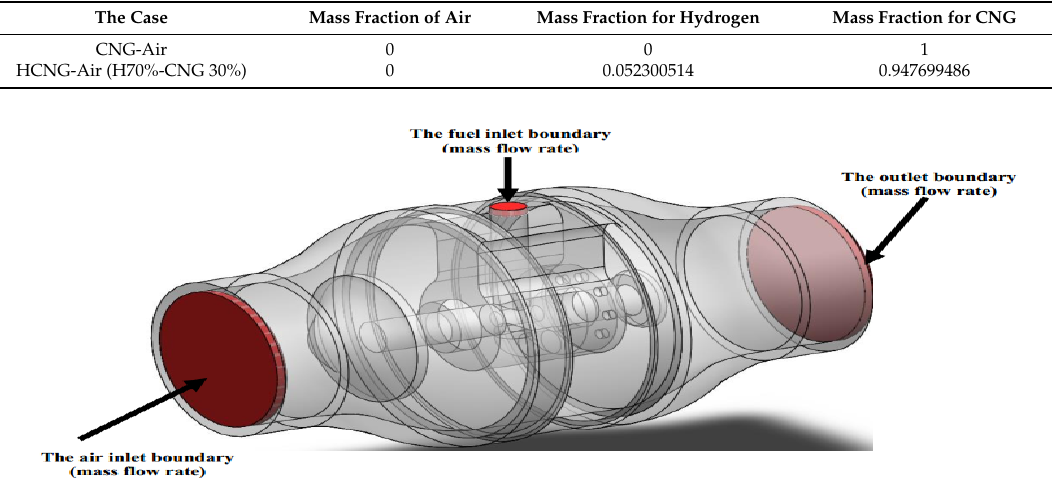
Figure 11. The boundary conditions for three-dimensional mixer.